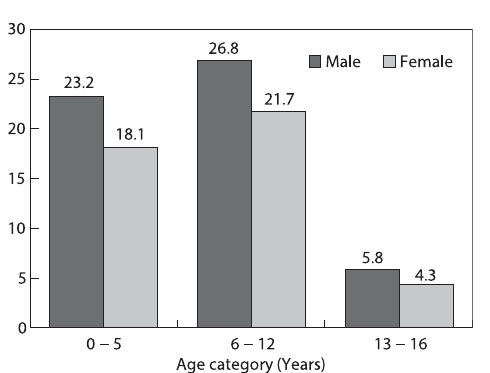
Figure 2: Distribution of children diagnosed with acute hepatitis A by age group and gender.